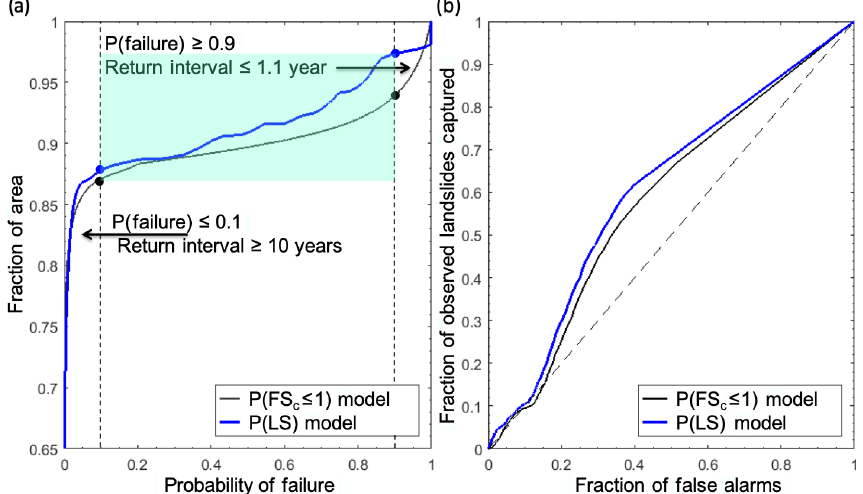
Figure 10. (a) Cumulative distribution of the probability of failure for the P (FS c ≤ 1 ) (black) and P (LS) (blue) using only the debris avalanche source areas. (b) ROC curves for the same two datasets. The blue shaded area on (a) represents the fraction of the landscape with 0 . 1 ≤ P (Failure) ≤ 0 . 9. Black diagonal dashed line on a 1 : 1 line in (b) represents the case of a trivial or random classification model. AUC values are 0.58 for the modeled probability and 0.60 for the integrated